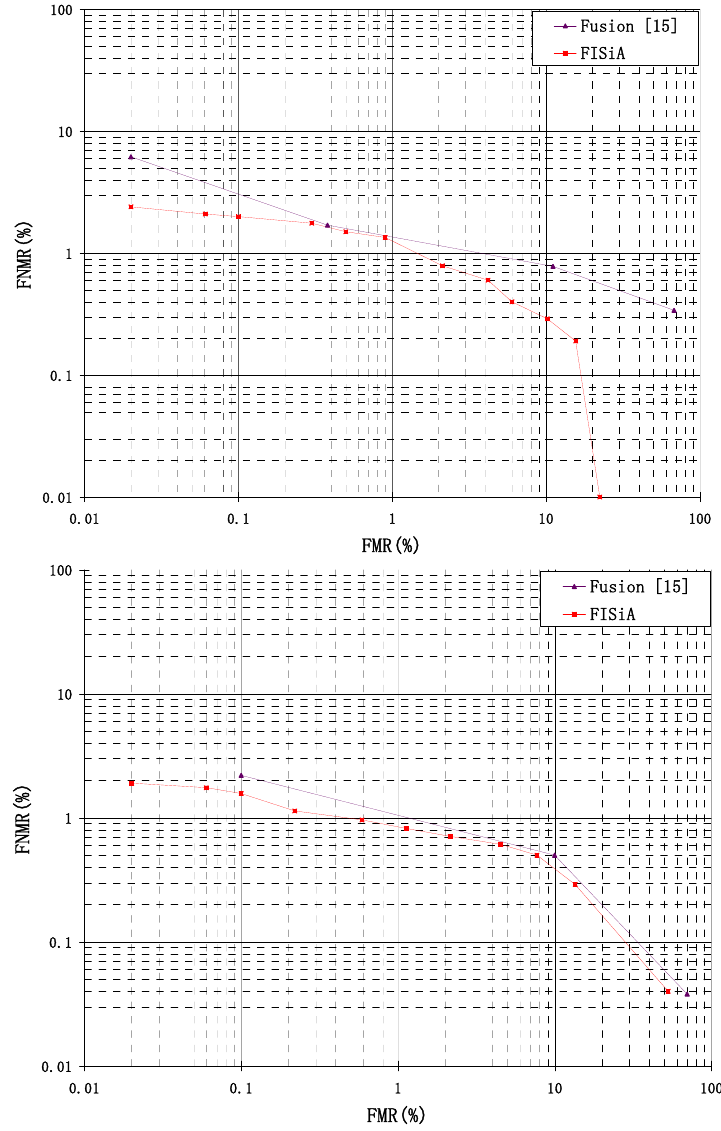
Figure 13. ROC curves of Fusion [15] and FISiA on FVC2002 DB1 and